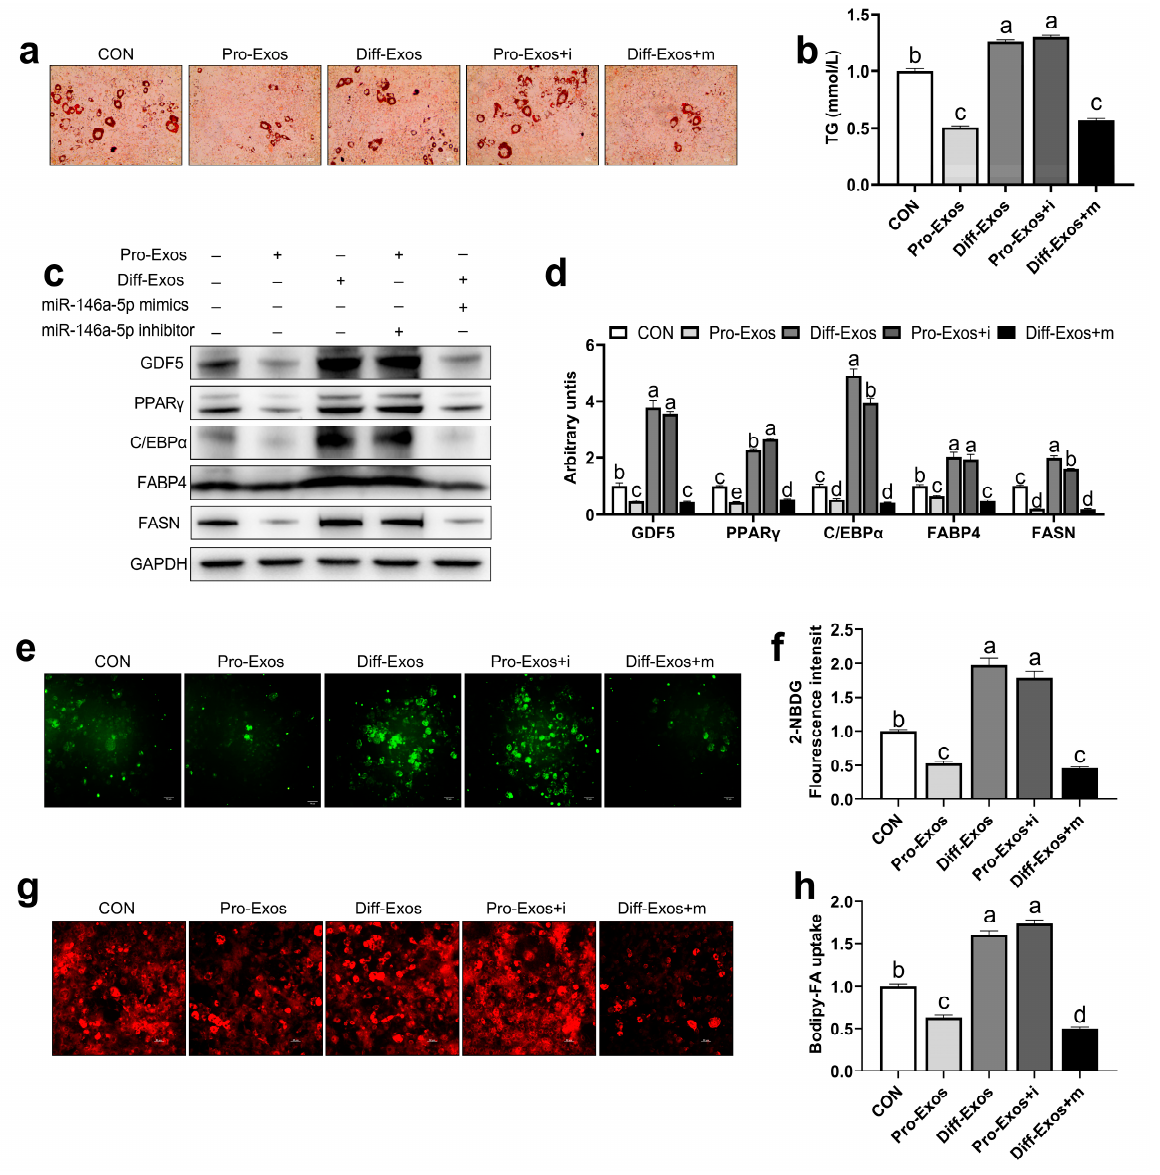
Figure 2. miR-146a-5p reversed the effect of skeletal muscle-derived exosomes on adipogenesis, glu- cose uptake, and fatty acid absorption in 3T3-L1 cells. ( a ) After treatment of exosomes (Pro-Exos, Diff-Exos) and transfections of miR-146a-5p mimics and miR-146a-5p inhibitor, 3T3-L1 adipogenic precursor cells were induced to mature, and oil red O staining was performed (scale bar = 50 μ m). ( b ) After treatment with exosomes (Pro-Exos, Diff-Exos) and transfecting miR-146a-5p mimics (mimics) and miR-146a-5p inhibitor (inhibitor), 3T3-L1 adipocytes were induced to mature, and TG content was assayed (n = 6). ( c , d ) After treatment of exosomes (Pro-Exos, Diff-Exos) and transfec- tions of mimics and inhibitor, adipogenesis-related proteins and fatty acid synthesis-related protein bands were detected by Western Blot in mature 3T3-L1 cells (n = 4). ( e ) 2-NBDG fluorescence profile of 3T3-L1 cells after treatment of exosomes (Pro-Exos, Diff-Exos) and transfections of mimics and inhibitor for 24 h (scale bar = 50 μ m). ( f ) 2-NBDG fluorescence values of 3T3-L1 cell after treatment of exosomes (Pro-Exos, Diff-Exos) and transfections of mimics and inhibitor for 24h (n = 6). ( g )